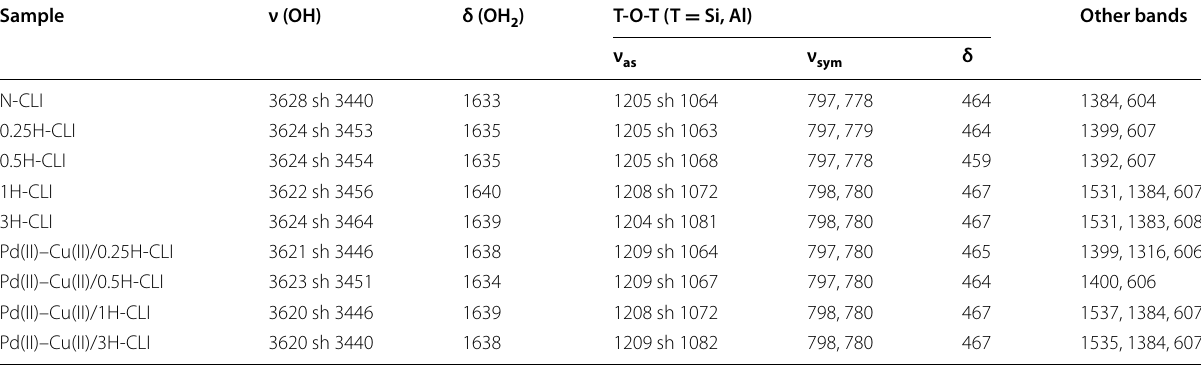
Table 2 Wave numbers (cm − 1 ) of absorption band maximums in FT-IR spectra of N-CLI, H-CLIs, and Pd(II)–Cu(II)/H-CLIs Sample